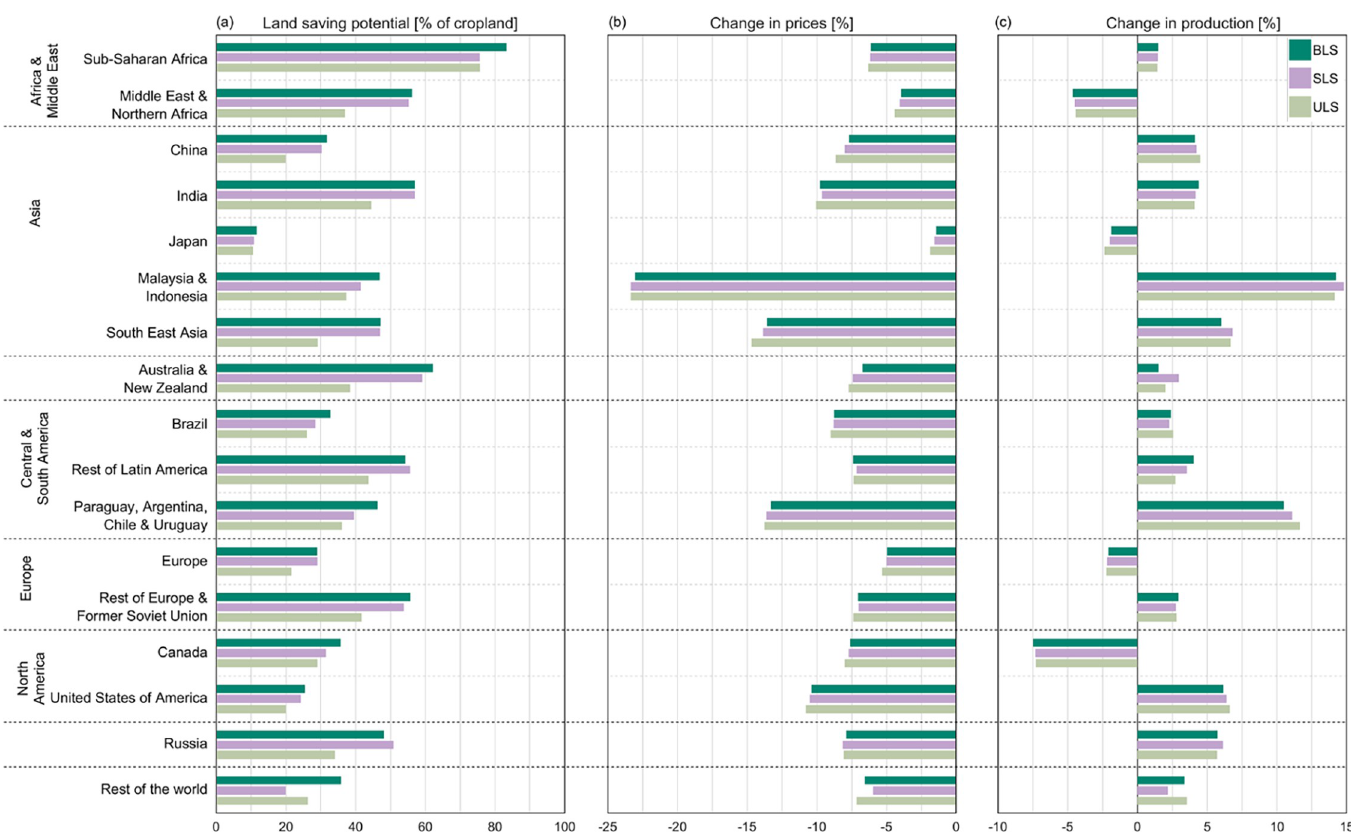
Fig 3. Regional potentials of land saving (a) and resulting regional effects on agricultural markets in terms of changes in crop prices (b) and production (c) for each land saving strategy. Land saving potentials [%] describes the percentage share of cropland that could be taken out of production relative to the total regional cropland across all crop categories. The relative changes in prices and production [%] refer to a baseline without the implementation of land saving.